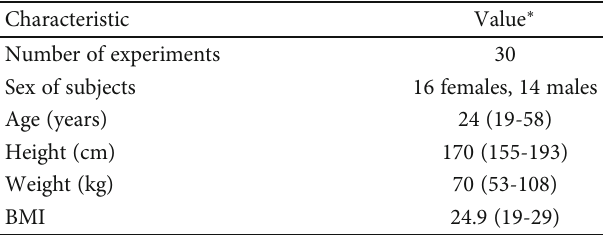
Table 1: Characteristics of the blood